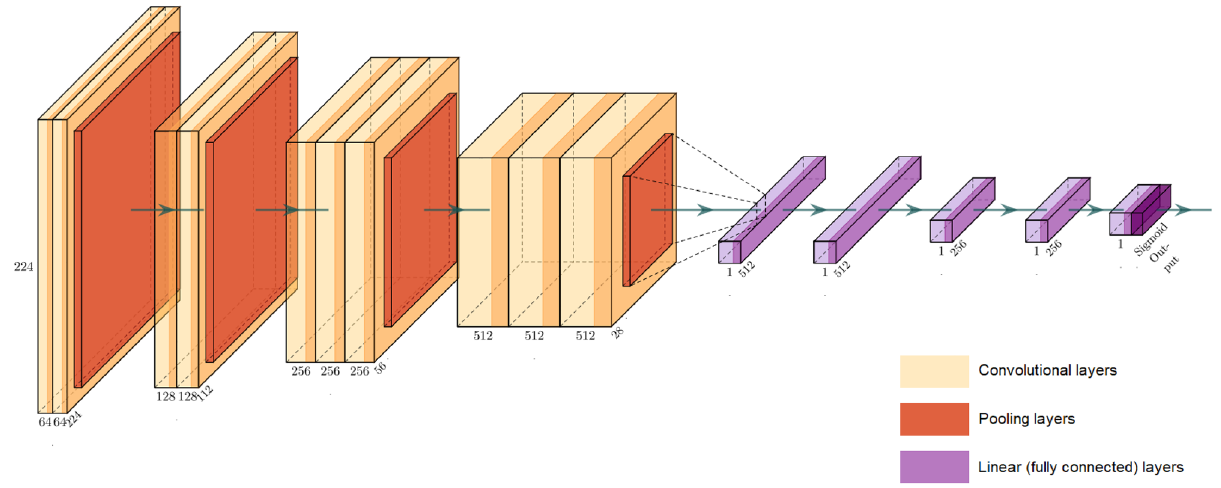
Figure 3. Architecture of the modified VGG16 model trained for this